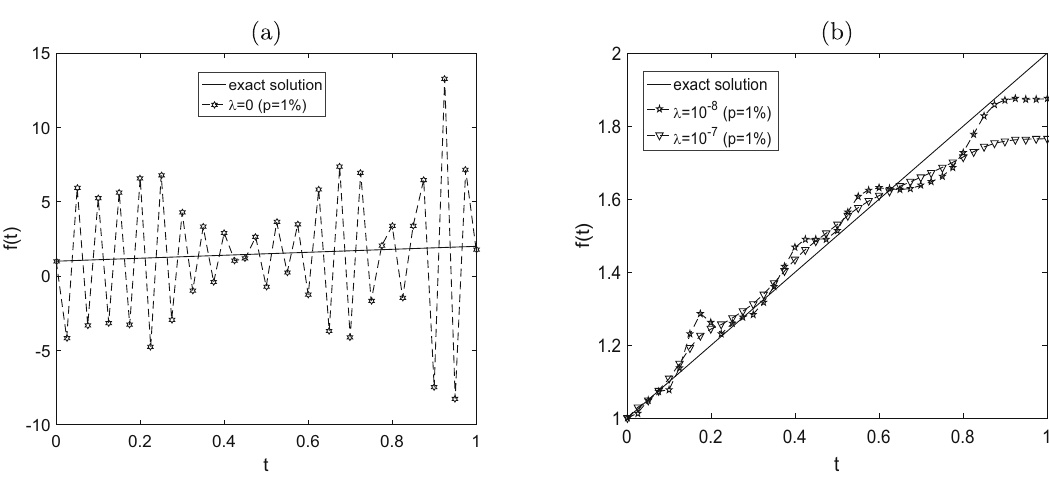
Figure 5: The exact ( 77 ) and approximate ( ) f t , for = p 1% with λ : ( a ) 0 and ( b ) 10 , 10 −8 −7 , for